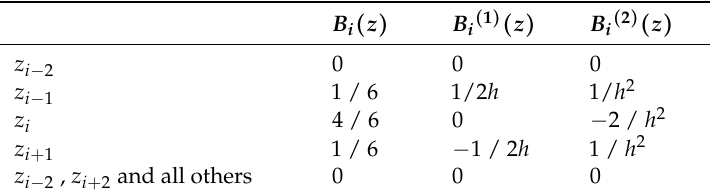
Table 1. Values of B ( z ) , B ( 1 ) ( z ) and B ( 2 ) ( z ) at the